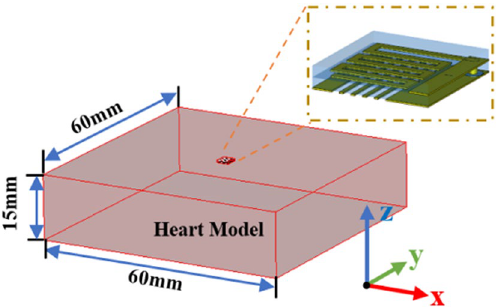
Figure 3. Schematic diagram of antenna implantation simulation heart tissue